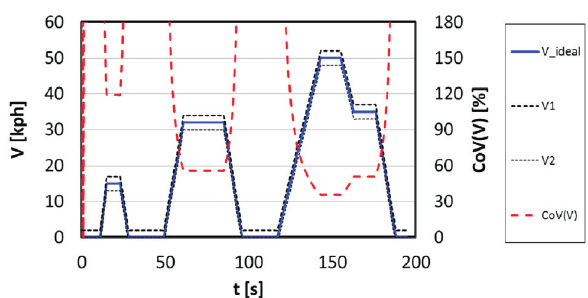
Fig. 1. Evaluation of the coefficient of variation from the mean value in the UDC test comprising a part of the NEDC test